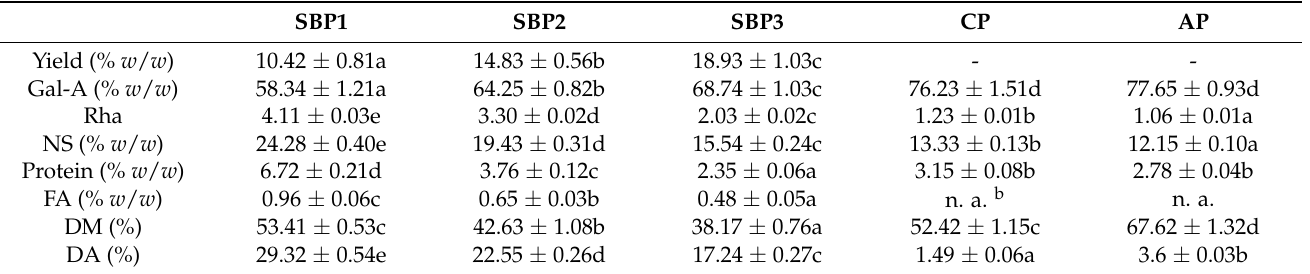
Table 1. Yield and chemical composition of pectin used in this work a